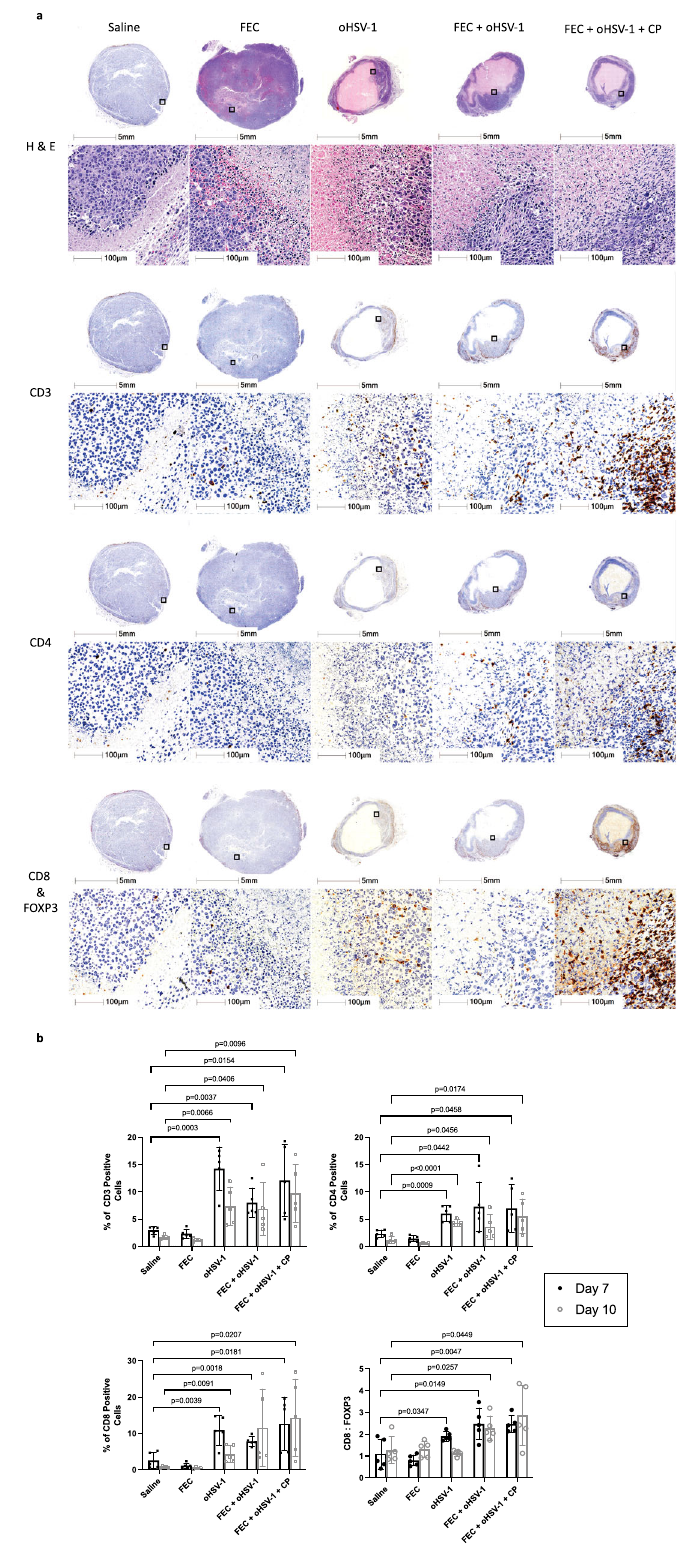
Fig. 4 Immunohistochemistry analysis shows that oHSV-1, FEC + oHSV-1, and FEC + oHSV-1 + CP treatments induce TILs. C57/Bl6 mice bearing E0771 tumors were treated with saline, FEC, oHSV-1, FEC + oHSV-1 or FEC + oHSV-1 + CP and tumors were harvested on day 7 ( n = 5 per group). Tumors were sectioned and stained with H&E for pathological analysis. Sections were then further stained with antibodies for CD3, CD4, CD8 α , and FOXP3. a Representative images for tumors harvested on day 7. Each image shows a whole section of an individual tumor. b Whole tumor sections were scanned and quanti fi ed using HALO quanti fi cation software. Each symbol represents an individual mouse within that group. Two-tailed paired t test was used for statistical analyses. Error bars are representative of the standard